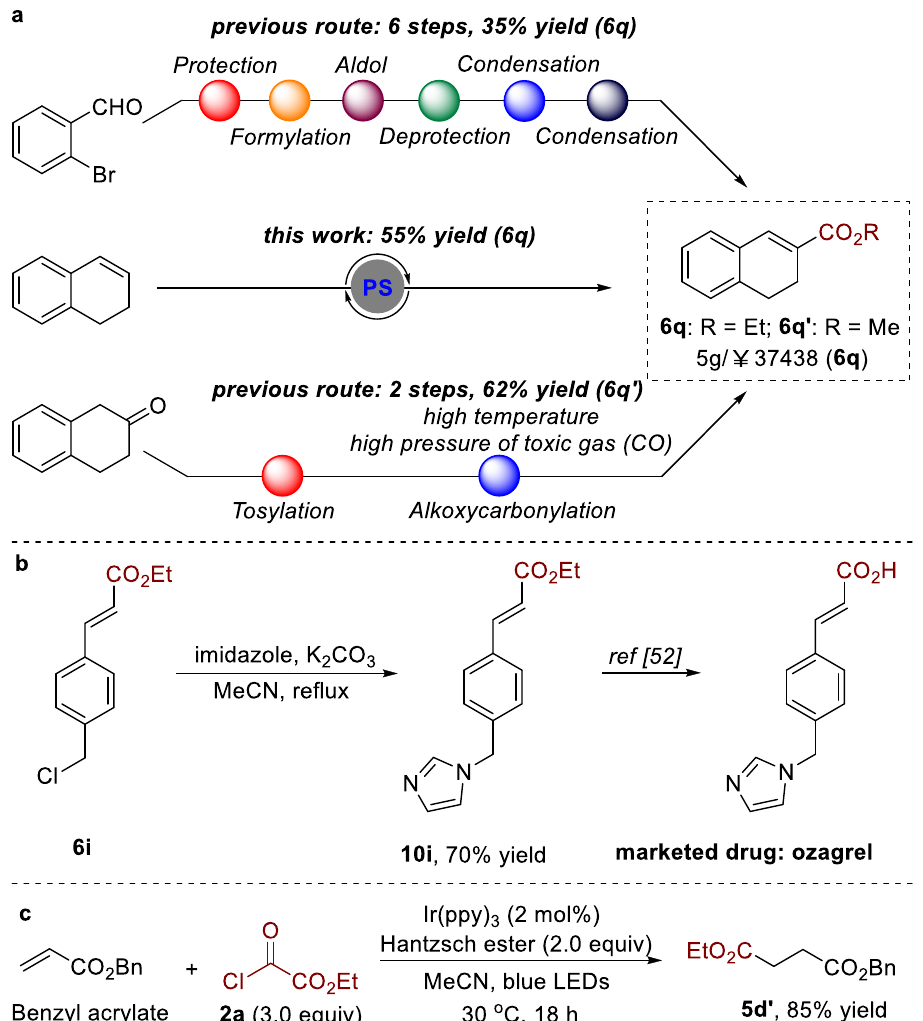
Fig. 7 Synthetic application. a Synthesis of expensive dihydronaphthalene derivative. b Formal synthesis of marketed drug ozagrel. c Synthesis of 1,4- dicarbonyl